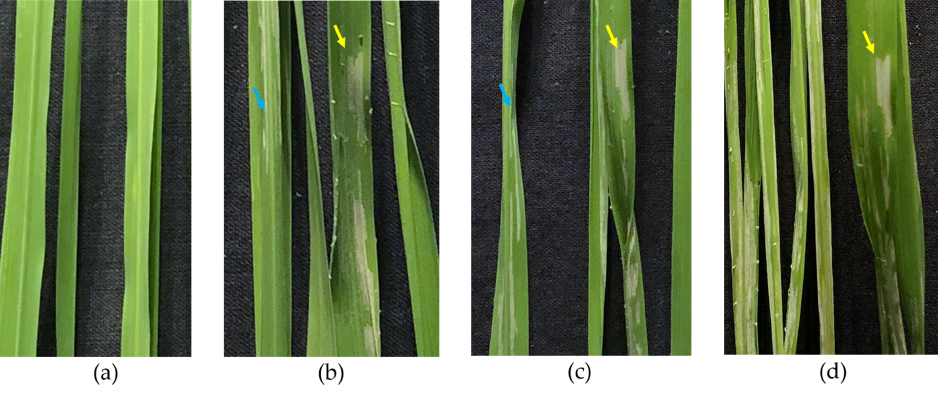
Figure 2. Appearance of healthy and damaged leaf types. ( a ) Healthy leaves, ( b ) lineal white stripe (LWS) caused by RLF (blue arrow) and LWS enlarge into ocher patch (OP) (yellow arrow) on Day 1 (D1), ( c ) LWS and OP on D2, and ( d ) OP on